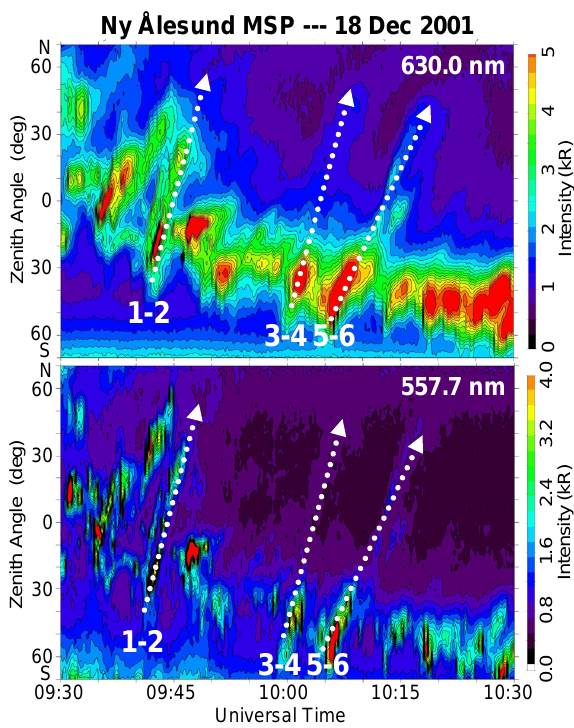
Fig. 2. Meridian scanning photometer data from Ny- ˚Alesund, Sval- bard. The upper panel shows the recorded intensities for the 630.0- nm (red line) and the lower panel the 557.7-nm (green) line. White dotted lines indicate three poleward moving auroral forms (1–2, 3– 4, 5–6) that occurred between the respective flow channels identi- fied in Fig.